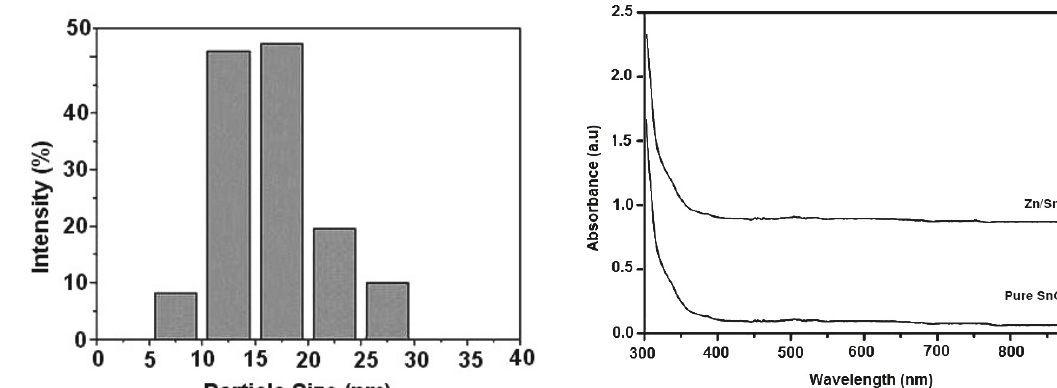
Fig.5. Particle size of Zn-doped SnO2 nanoparticles